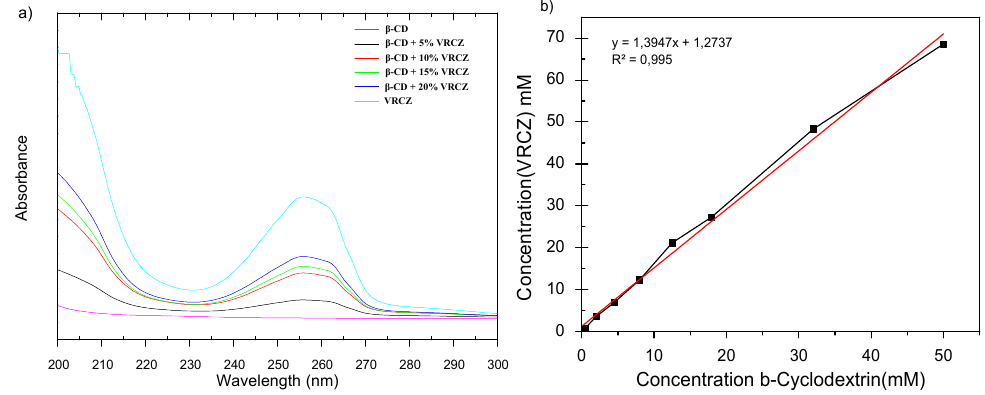
Figure 5. ( a ) UV-VIS spectroscopy and ( b ) phase solubility studies of β -CD/VRCZ inclusion complexes. (Red line is associated as trend line).